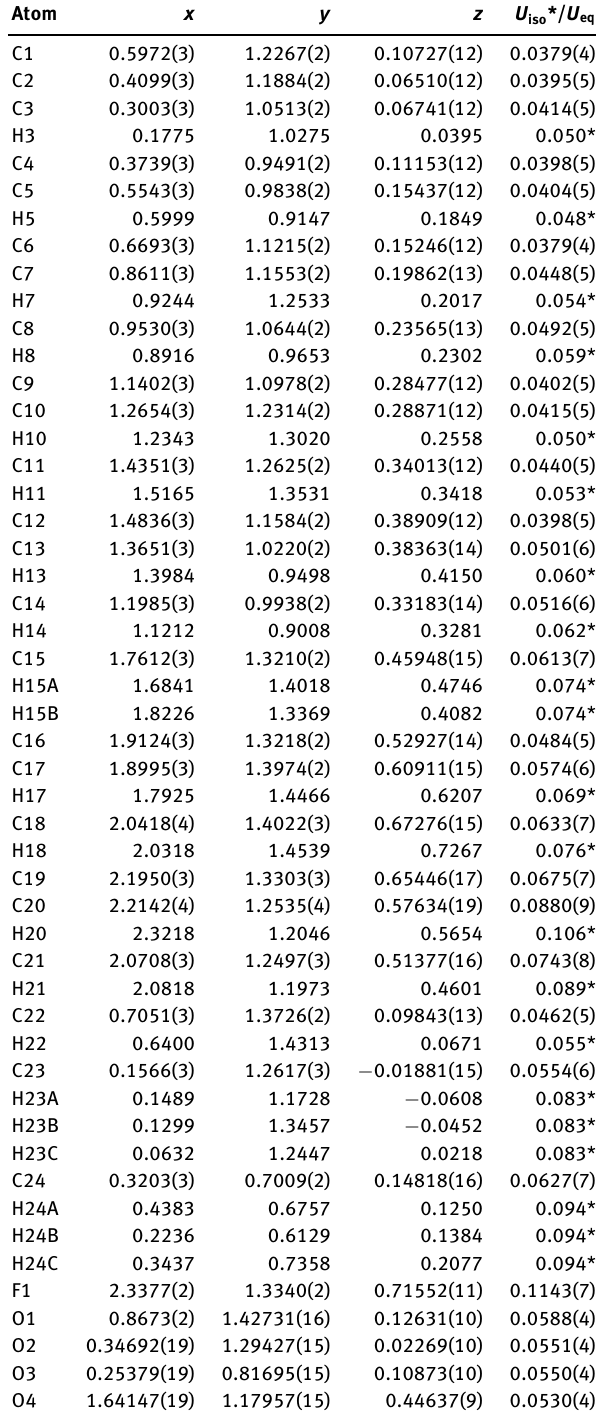
Table 2: Fractional atomic coordinates and isotropic or equivalent isotropic displacement parameters (Å 2